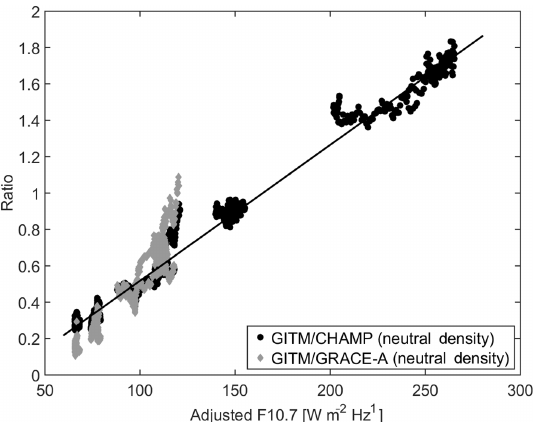
Figure 22. Effect of the solar activity on a large dataset of GITM simulations in comparison with CHAMP and GRACE neutral den- sities. The solid line represents the linear interpolation of all neutral density ratios.